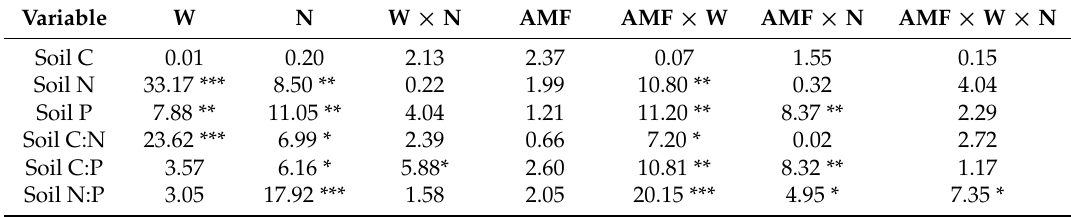
Table 3. Results of three-way factorial analyses of variance (ANOVAs) of the effects of warming, N input and arbuscular mycorrhizal fungi (AMF) on soil total C, N, and P contents and ratios of C:N, C:P, and N:P.